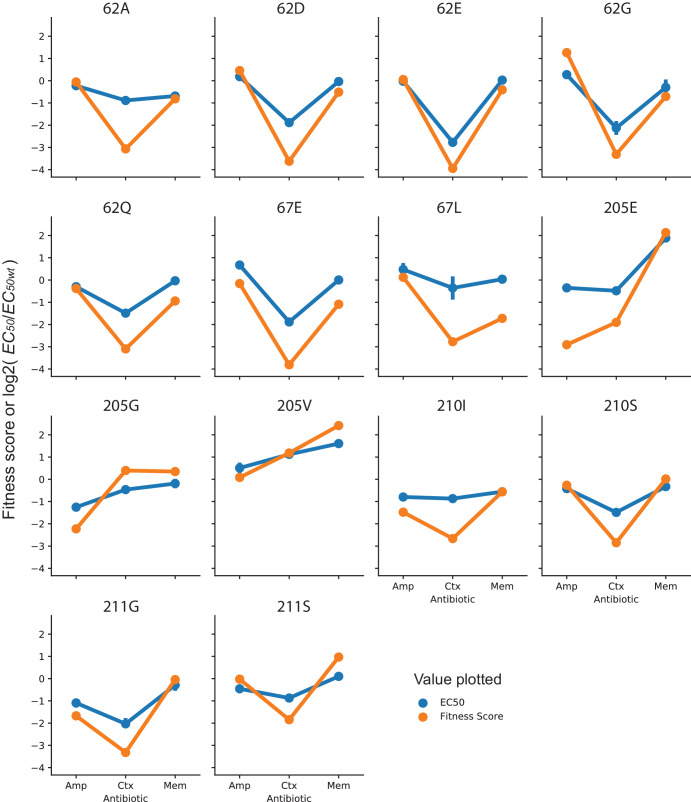
Comparison of fitness scores and EC50 of specificity variants.Each plot shows the fitness score obtained from DMS (128 µg/mL AMP, 4.0 µg/mL CTX and 0.031 µg/mL MEM) or the EC50 fitted from a dose response curve for the variant indicated. Fitness scores are plotted directly, while EC50 values have been normalized to log2(EC50/EC50
wt) to allow them to be compared on the same scale as the fitness scores. EC50 values of the same amino acid variants (different codon variants or same codon variants isolated and measured multiple times) show the average EC50 with error bars indicating the 95% confidence interval.